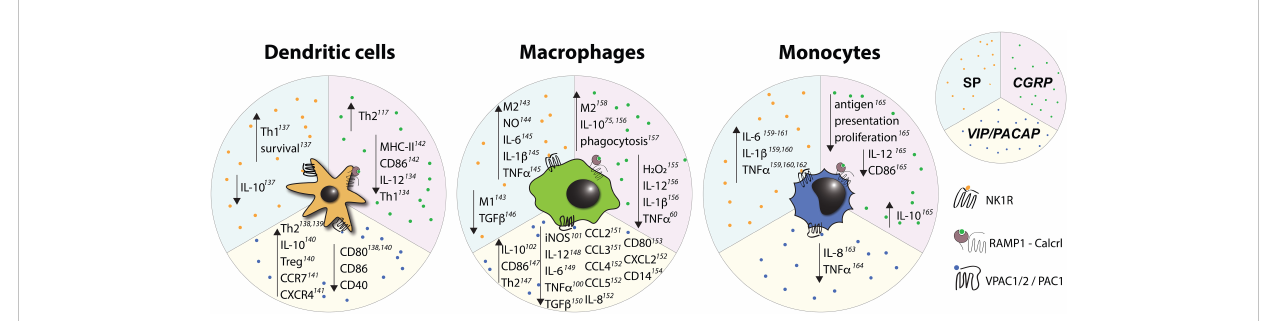
FIGURE 5 Effects of select nociceptive neuropeptides on mononuclear phagocytes observed in vitro . Upward pointing arrows signify upregulation/activation, downward facing arrows signify downregulation/inhibition.